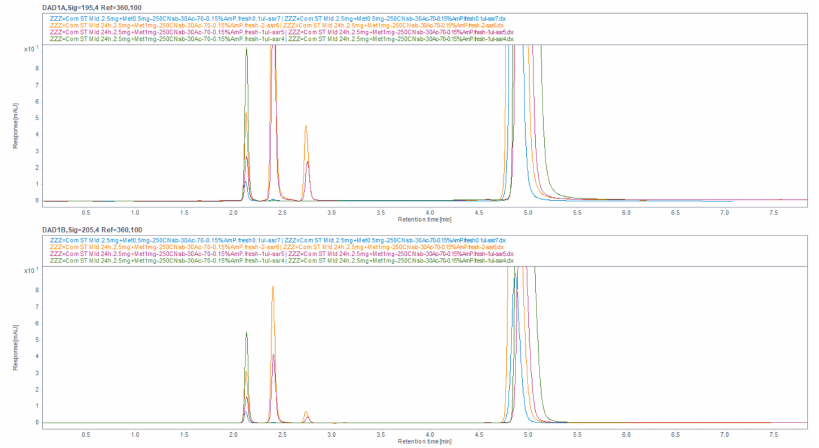
Figure 38. Chromatograms, obtained by usage mobile phase composed of 30% ACN and 70% 13 mM NH 4 H 2 PO 4 , and achieved better resolutions function of increased retention, and overall run time of about 5 min, but significant peaks increased resolution. Overlaid 2 different situations of samples, freshly prepared and incubated for 3 days at room conditions. The first peak was meldonium, the second and third were degradation products, and the last one was metoprolol. The sizes of the peaks were different due to increasing injection volumes.